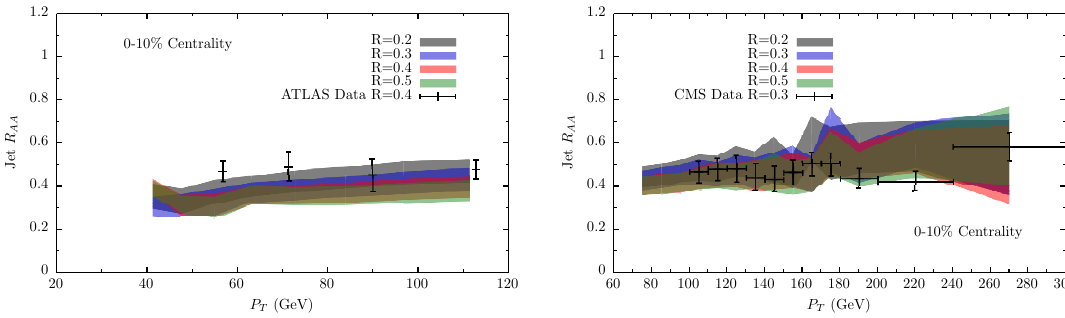
Figure 8 . Dependence of jet R AA on the anti- k t parameter R used in reconstructing the jet and on the transverse momentum of the jet. We have set K = 0, turning o(cid:11) transverse momentum broadening which we saw in section 3 has only very small e(cid:11)ects on this observable. We have included the e(cid:11)ects of the wake in the hydrodynamic (cid:13)uid, which is to say the backreaction of the medium to the presence of the jet, and have added a background and implemented two di(cid:11)erent background subtraction procedures as described in the text and in appendix B. The left plot shows this observable for jets with 40 < p Tjet < 120 GeV as measured by the ATLAS collaboration [56], with their background subtraction procedure, while the right one is for jets with 70 < p Tjet < 300 GeV as measured by the CMS collaboration [49], with their background subtraction procedure. Both panels are for the 0-10% most central collisions with p s = 2 : 76 ATeV. We have extended the p T -range in the right panel down to 70 GeV even though present CMS measurements are for jets in the range 100 < p Tjet < 300 GeV to make it possible to compare the results from our model in the p T -range where the two panels overlap in order to see the e(cid:11)ect on R AA of choosing between the two di(cid:11)erent background subtraction procedures. The di(cid:11)erence between the two panels is small, but